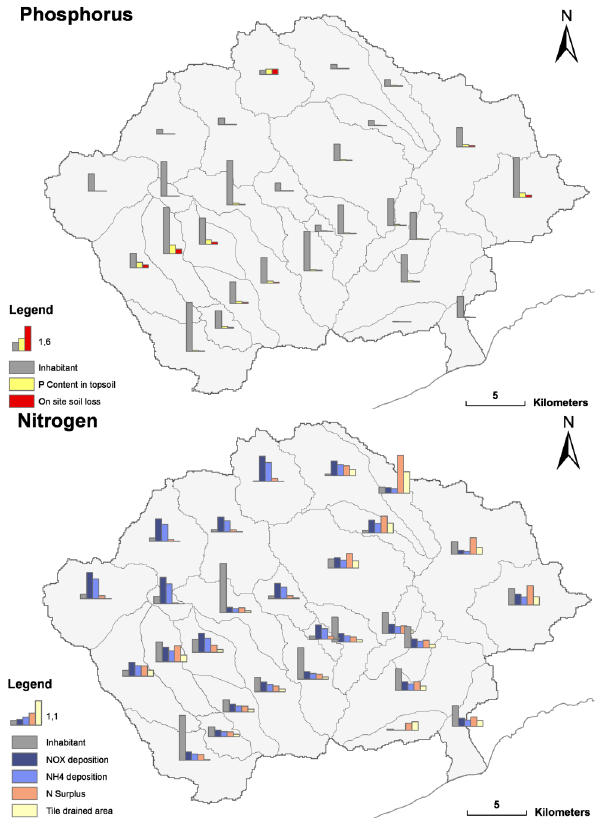
Fig. B1. Model sensitivity to input parameters for phosphorus (top) and nitrogen (bottom) in La Tordera